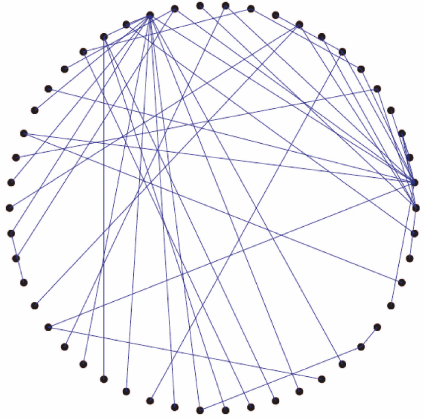
Figure 6: The structure of BA scale-free networks with 𝑁 = 50 (Example 11).